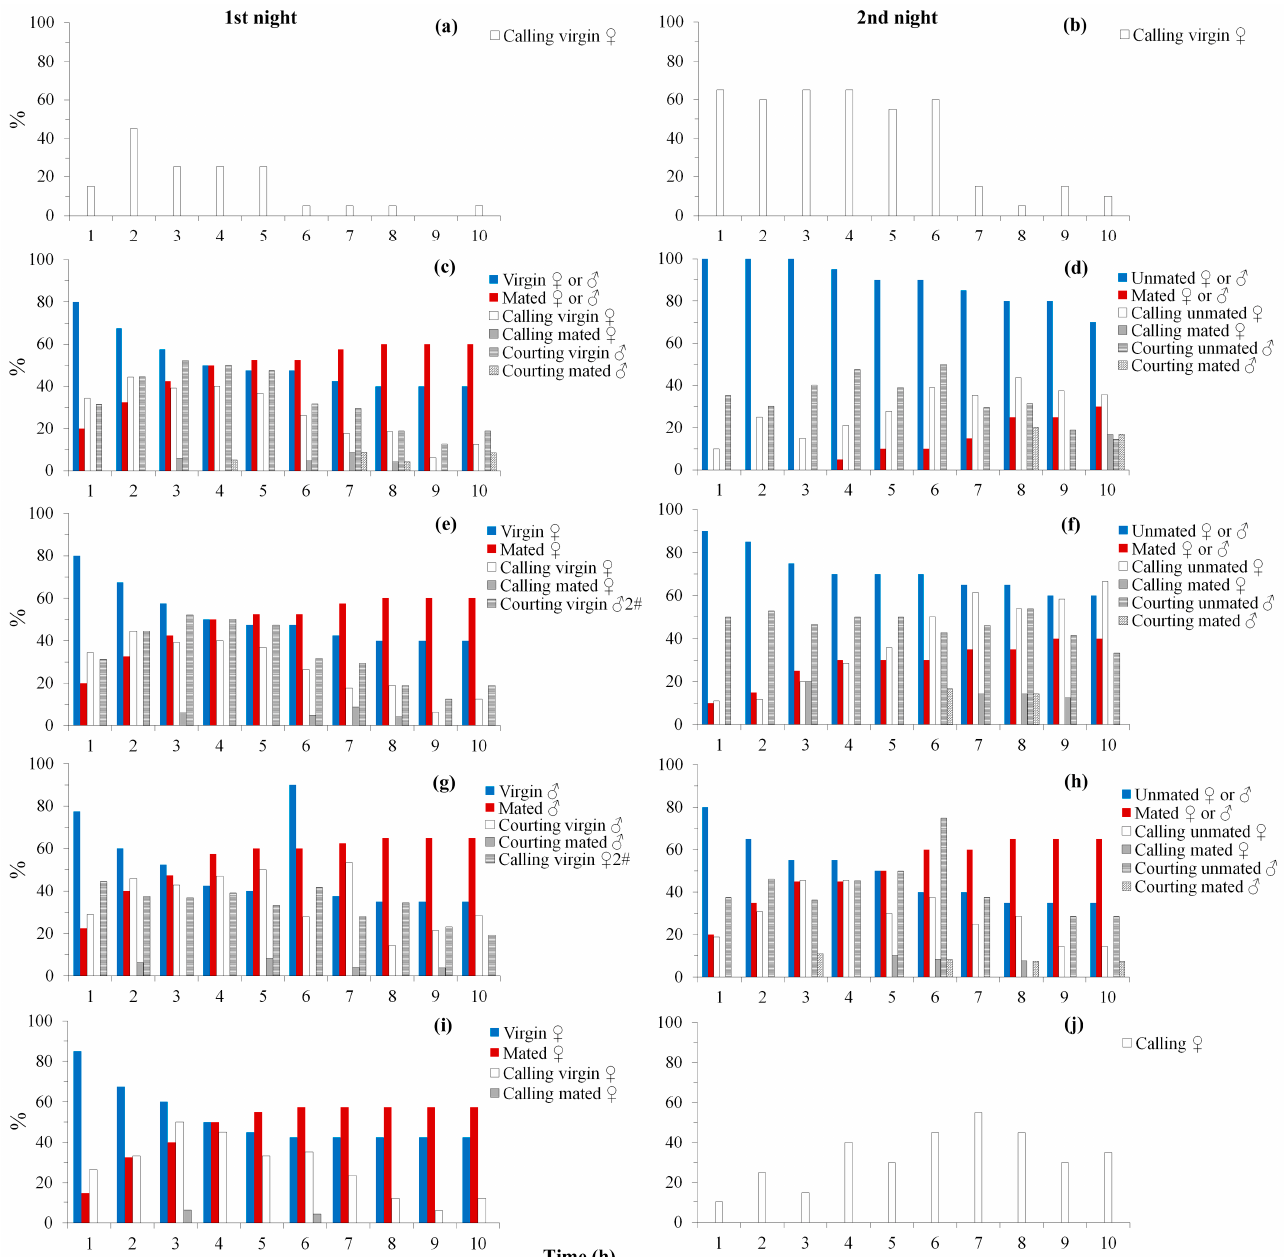
Figure 1. Reproductive behavior before and after mating, under different mating conditions, in S. frugiperda . ( a , b ) are behaviors of singly caged virgin females; ( c , d ) are behaviors of females and males from paired; ( e , f ) are behaviors of females and males (male 2#) from change male mate; ( g , h ) are behaviors of males and females (female 2#) from change female mate; ( i , j ) are behaviors of one-time mated females. The observation was performed for two nights. In each night, the percentages of mated males or females are accumulated values, and the percentage of virgin or unmated males or females = 100% − the percentage of mated males or females, whereas the percentages of courting males, calling females and ovipositing females are the exact values of an hour, such that the percentage of ovipositing females of a given hour = the number of ovipositing females observed in this hour/the number of total females